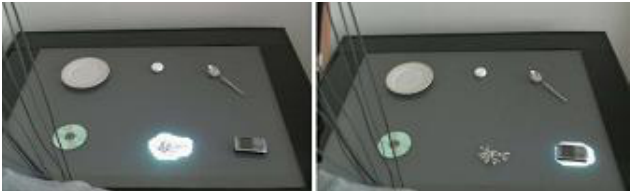
Fig. 6. Multitouch display interface, where objects are enlightened one by one, triggering a P300 wave. Source: